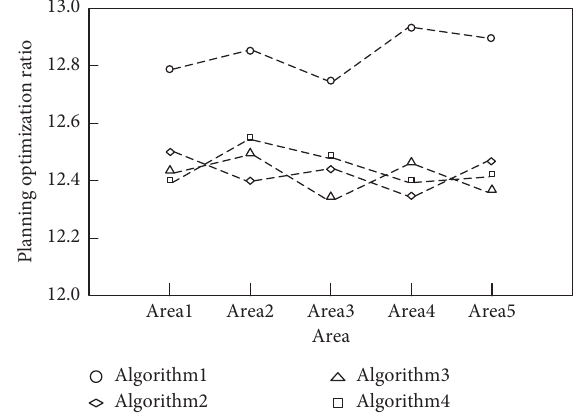
Figure 4: Optimal proportion of different